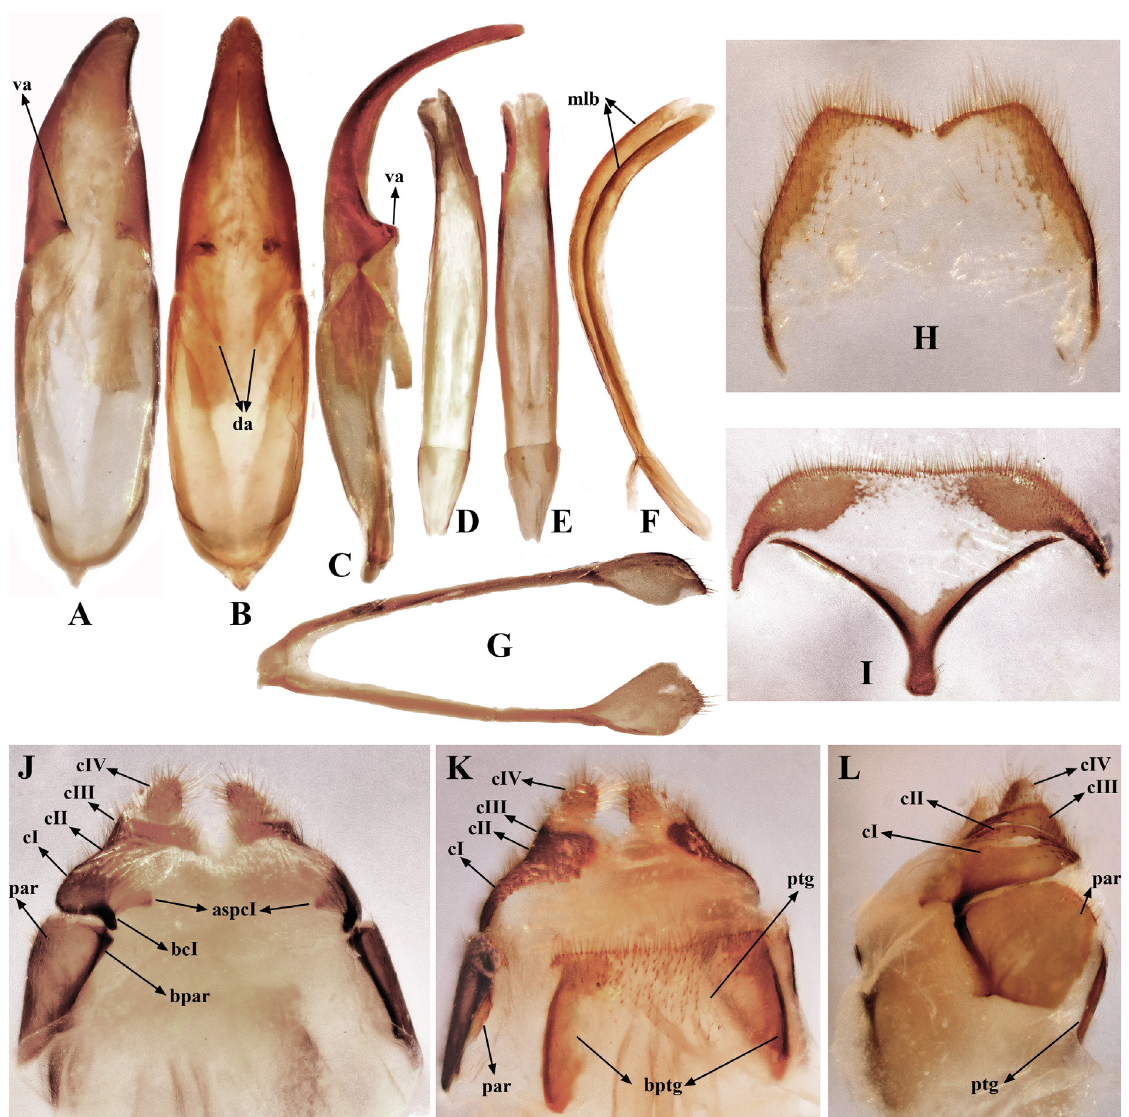
Fig. 15. Habrochiton vernus Semenov-Tjan-Shansky, 1907 (ZIN), genitalia. A . Tegmen of aedeagus, ventrally. B . Ditto, dorsally. C . Ditto, laterally. D . Median lobe, ventrally. E . Ditto, dorsally. F . Ditto, laterally. G . Spiculum gastrale. H . ♂, inner sternite VIII. I . ♀, inner sternite VIII and spiculum ventrale. J . Ovipositor, ventrally. K . Ditto, dorsally. L . Ditto, laterally. Not to scale. Abbreviations: see Material and